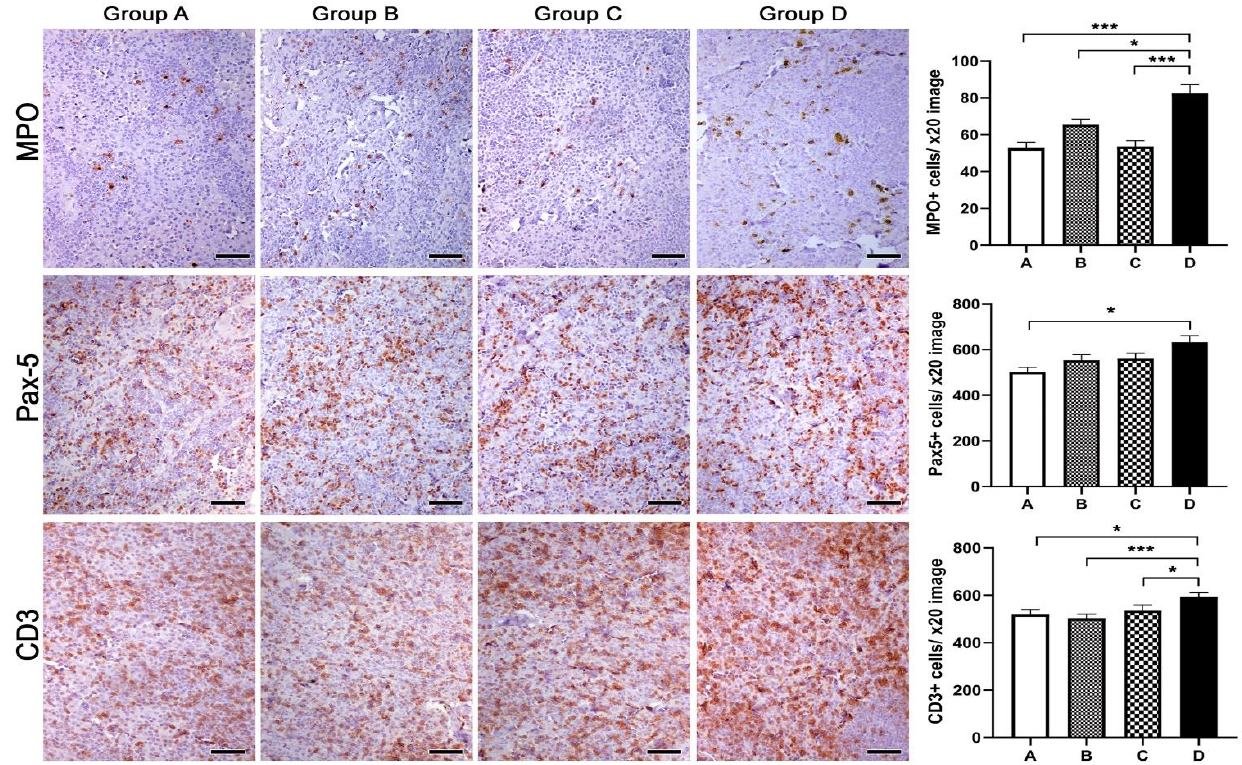
Figure 8. Effects of Spirulina treatments on inflammatory cells in paracortical areas of mesenteric lymph nodes of mink progeny. A Spirulina diet in progeny (group C), mothers (group B) or both (group A) connected with decreased numbers of granulocytes (MPO), B-lymphocytes (PAX-5) and T-lymphocytes (CD3) in the mesenteric lymph nodes compared to the non-treated control group (group D). Morphometric counts of immunohistochemically labeled inflammatory cells showed statistically significant differences among experimental groups, as highlighted in the bar graphs. IHC: diaminobenzidine chromogen, hematoxylin counterstain. Scale bars: 50 µ m. Numbers on the y-axes of bar graphs correspond to the means ± SEM of immune cell counts * p < 0.05, *** p < 0.001. Letters of the x-axes correspond to the experimental groups (A, B, C,